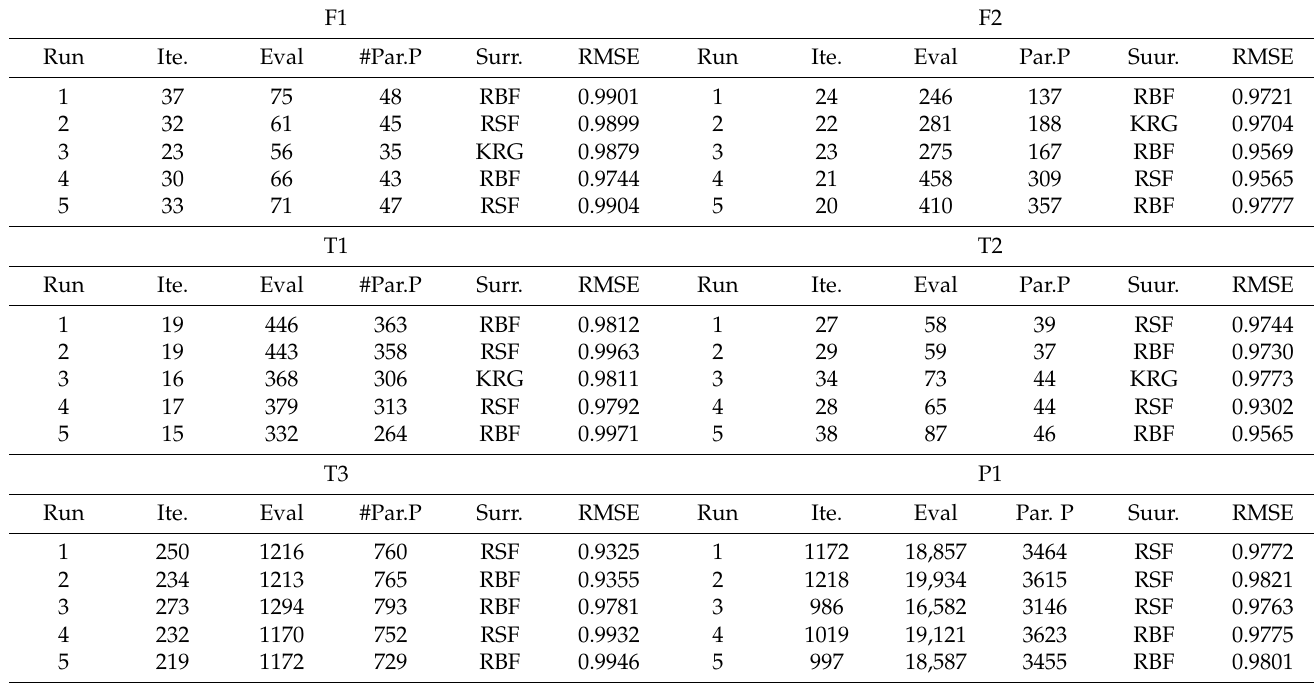
Table 2. Test results of the introduced algorithm on multi-objective test